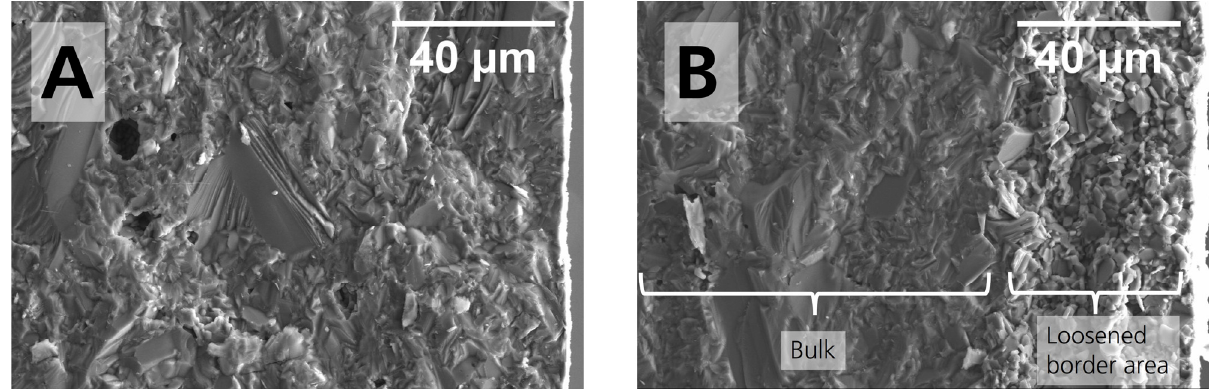
Figure 3. Cross-section’s SEM images with enhanced magnification close to the right edge for the ( A ) pristine sample and ( B ) sample stored for 28 days in 44% r.h. The white rectangle shows one of the right side’s three EDX analysis areas.